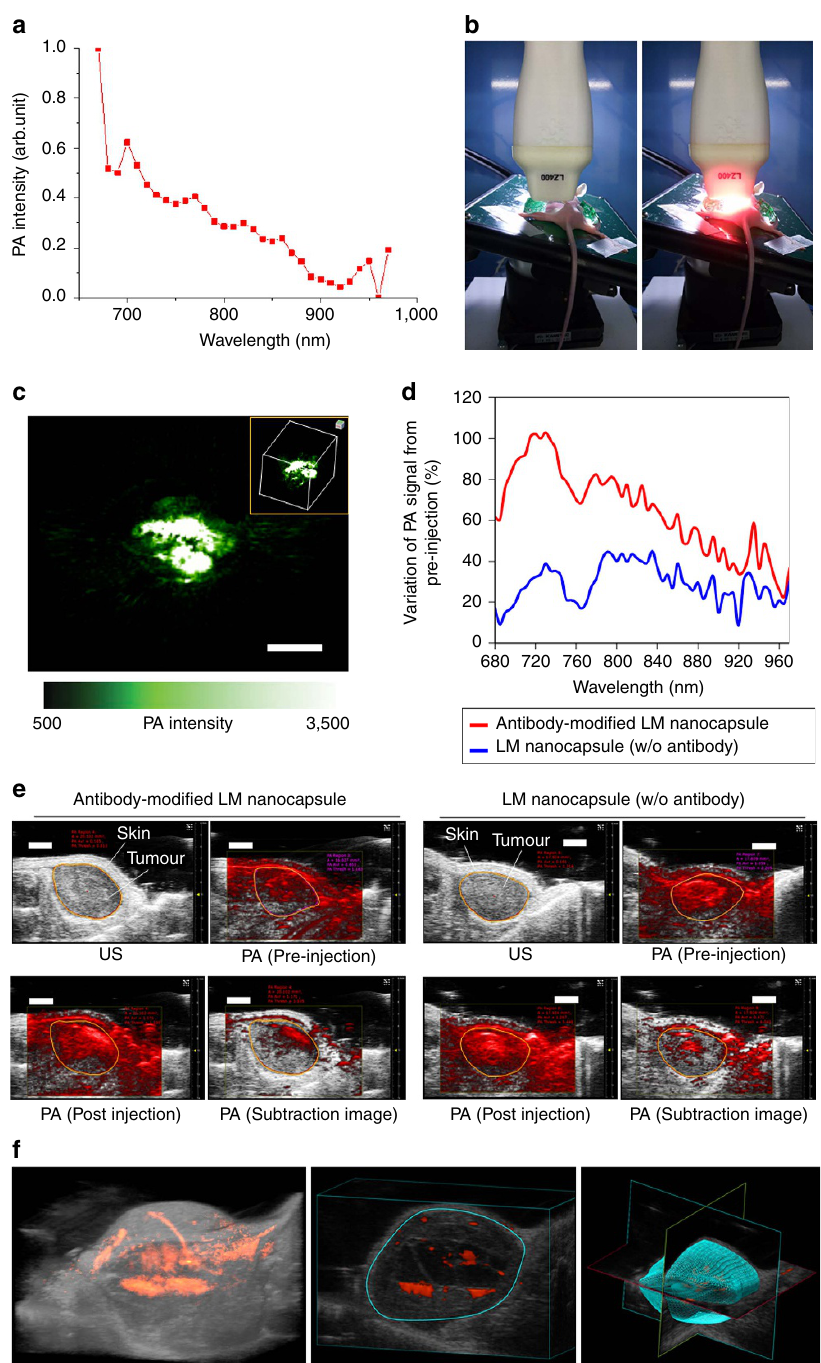
Figure 10 | In vivo PA imaging using LM nanocapsules. ( a ) PA intensity of LM nanocapsules (100 m gml (cid:2) 1 ) at different wavelength. ( b ) Photos of in vivo PA imaging set-up before (left) and after laser exposure (right). ( c ) PA (green) image of LM nanocapsules (100 m gml (cid:2) 1 ) under a mouse’s skin. Excitation wavelength of laser is 680nm. Inlet shows the 3D image of subcutaneous localization of LM nanocapsules. Scale bar, 4mm. ( d ) Enhancement of PA intensity in tumour by antibody-functionalized LM nanocapsules (100 m gml (cid:2) 1 ) in wide wavelength range for laser excitation. Variations of PA signals were calculated as post-injections minus pre-injections. ( e ) Antibody-functionalized LM nanocapsules (100 m gml (cid:2) 1 ) targeted tumour imaging in living mice. Ultrasound (US) (grey) and PA (red) images were taken through the tumour by 750nm laser excitation. Orange circles show the analysing parts of the PA signal for Fig. 8d. Scale bars, 2mm. ( f ) 3D imaging of tumour treated by antibody-functionalized LM nanocapsules. Excitation wavelength of laser is 750nm. Blue circle shows the part for construction of 3D structure. 3D,